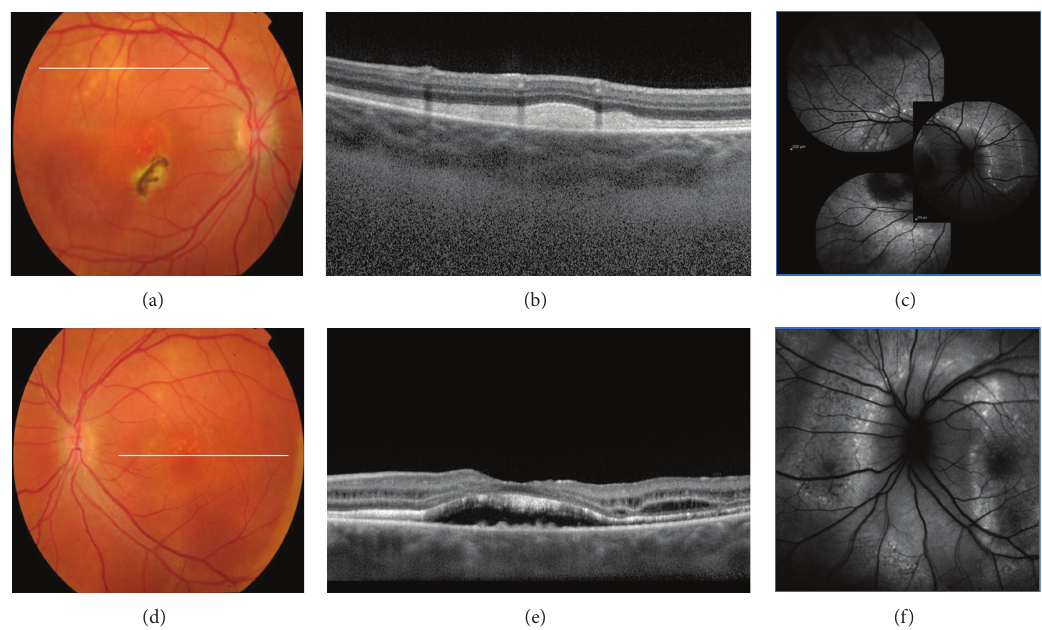
Figure 5: Fundus photograph of an autosomal recessive bestrophinopathy shows a well-demarcated area with round yellowish-white deposits at the posterior pole and along the superotemporal arcade; subretinal fibrosis is visible inferior nasal of the fovea. SD-OCT scan illustrates extensive RPE deposits extending to the outer plexiform layer. Fundus autofluorescence imaging displayed marked hyperautofluorescence corresponding to the yellow lesions. Fundus photograph shows a well-demarcated area with round yellowish-white deposits at the posterior pole extending to the superior periphery. SD-OCT scan demonstrates RPE detachment from the photoreceptors. Photoreceptor outer segments are thickened and elongated. Fundus autofluorescence identified additional peripapillary hyperfluorescent deposits not seen on funduscopy.